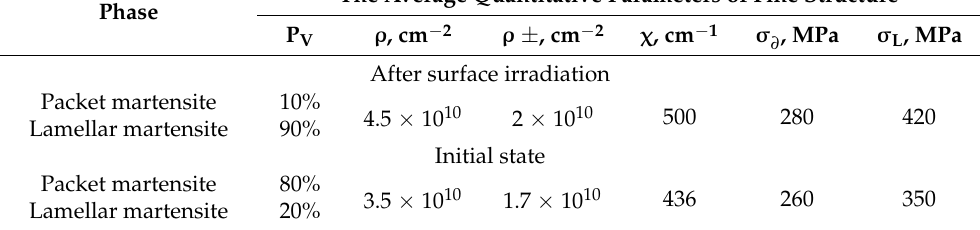
Table 1. Quantitative characteristics of the dislocation structure of morphological components of the α -phase of R6M5 steel before and after impact by an electron beam (electron microscopy data of the sample surface). The Average Quantitative Parameters of Fine Structure Phase P V ρ , cm − 2 Packet